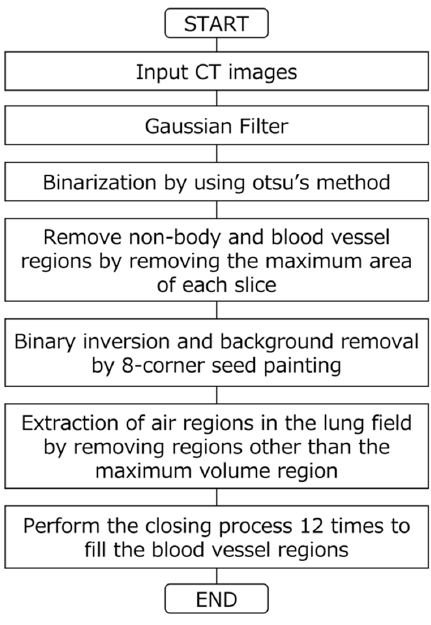
Appl. Sci. 2022 , 12 , x FOR PEER REVIEW Figure 2. Overall scheme for extraction method of lung field region. Figure 2. Overall scheme for extraction method of lung field region.